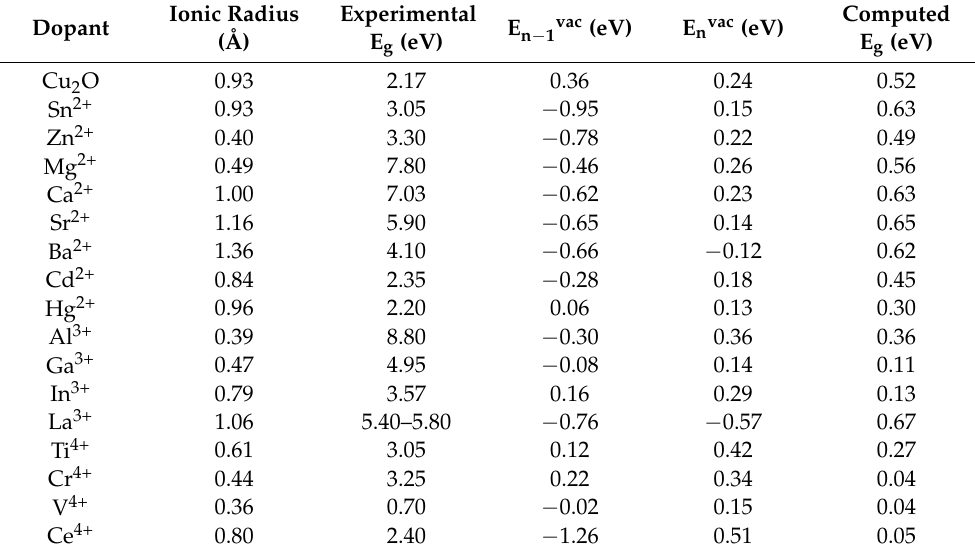
Table 4. Ionic radius and Cu vacancy formation energy (E vac ) and band gaps (E g ) for cation-doped Cu 2 O from [31], with permission from the American Chemical